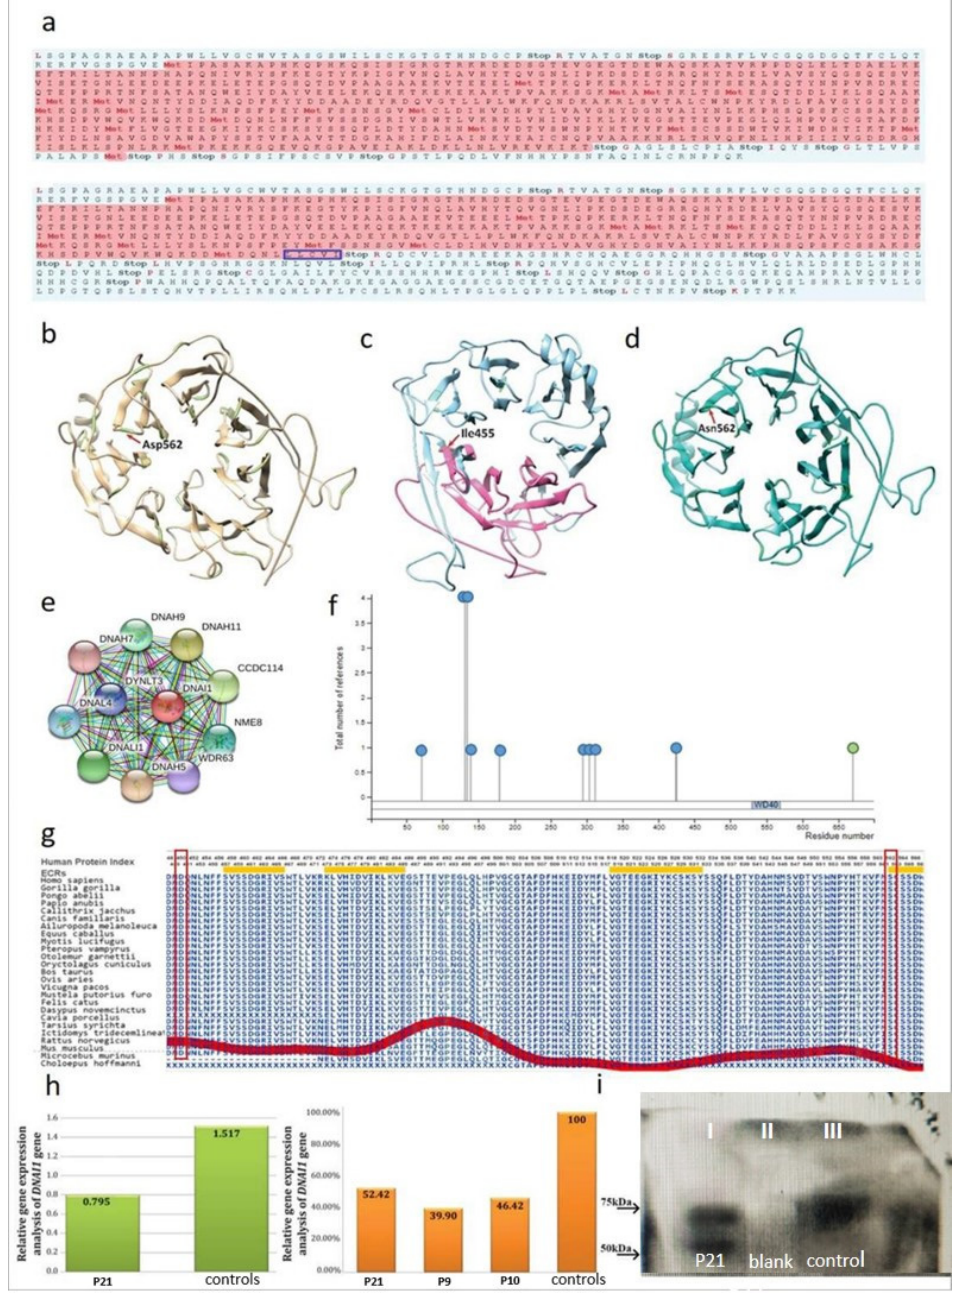
Figure 2. Three-dimensional molecular models of wild-type and mutated DNAI1 (dynein axonemal intermediate chain 1) proteins. In silico and functional analysis of the impact of the detected variants. ( a ) Translation of wild-type (upper figure) and mutated DNAI1 (lower figure) mRNA sequences. Frameshift mutation p.Asn450LeufsTer6led to a premature stop codon at position 456 in the polypeptide chain. The amino acid substitutions marked with a blue rectangle preceded the stop codon. ( b ) The three-dimensional model of the wild-type DNAI1 protein. ( c ) The three-dimensional model of the DNAI1 protein harboring frameshift mutation, p.Asn450LeufsTer6. The blue color shows the parts of the protein that are missing from the mutated protein, the pink color indicates the part of the protein that is common to wild-type and the mutated protein. ( d ) The three-dimen- sional model of the DNAI1 protein harboring missense mutation p.Asp562Asn. The codon for as- partic acid (GAC) at position 562 of the polypeptide chain is replaced with the codon for the amino acid asparagine (AAC). ( e ) Multiple protein–protein interactions of the wild-type DNAI1 protein